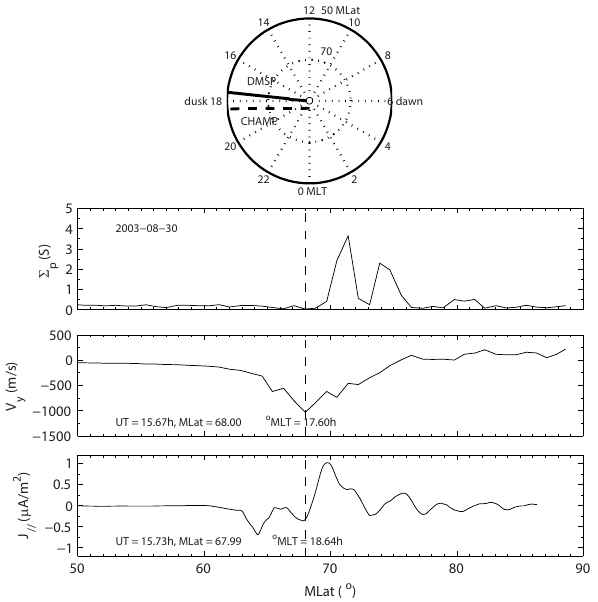
Figure 1. One example of a CHAMP-concurrent orbit in bin 2 (from MLT SAPS to MLT SAPS +2h) with respect to DMSP-detected SAPS. From top to bottom are CHAMP and DMSP orbit seg- ments in the ionosphere, ionospheric Pedersen conductivity and the plasma convection velocity in the east–west direction from DMSP, as well as field-aligned currents from CHAMP. The peak velocity of SAPS is indicated by the dashed line. The UT (universal time), MLat, and MLT are listed when DMSP and CHAMP pass the region where SAPS